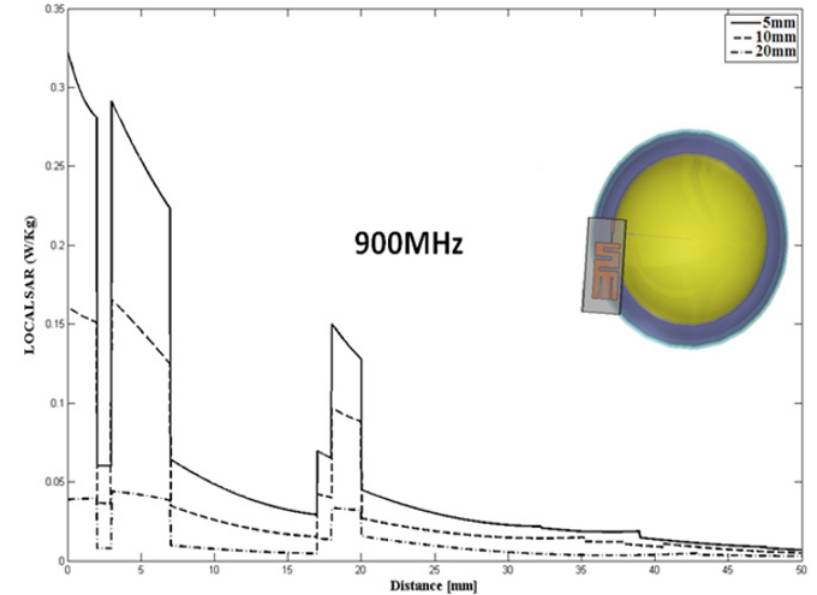
Figure 5. Local SAR variation at different patch antenna-head distances at 900 MHz.